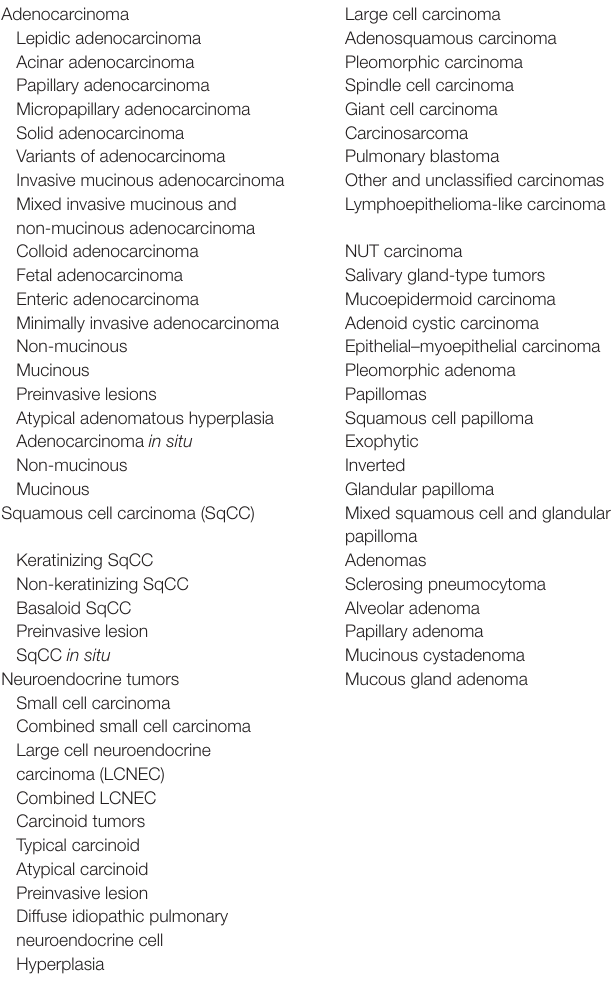
TAbLe 1 | WHO classification of tumors of the lung (epithelial tumors) (2).